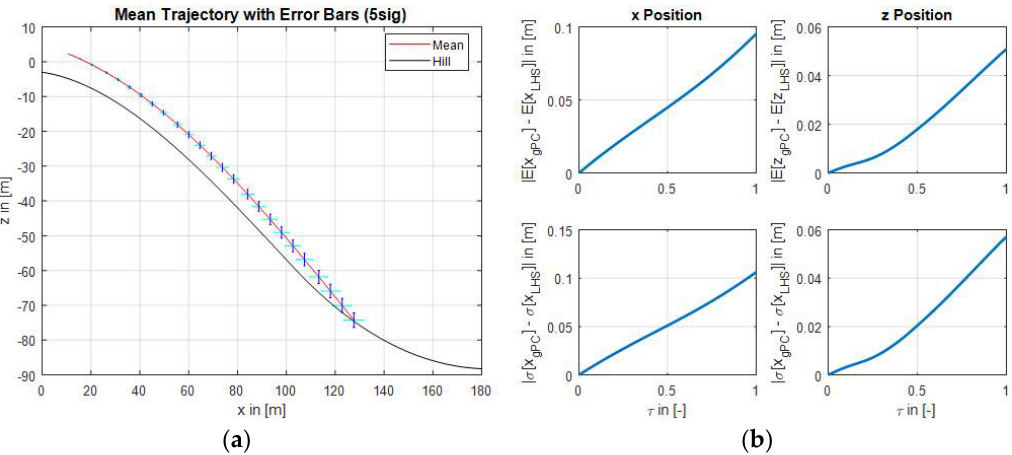
Figure 3. Optimized trajectory with uncertainty bars ( a ) and absolute error between gPC solution and LHS over non-dimensional time for position ( b ) on Okurayama hill.